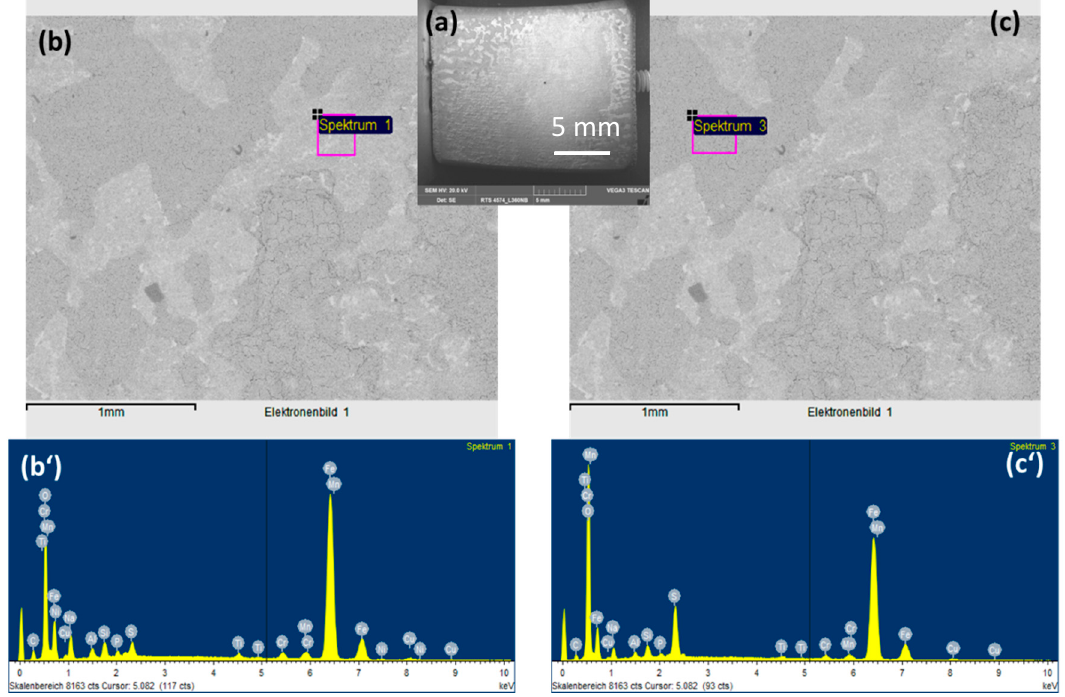
Figure 3. SEM images ( a , b , c ) and EDS spectra of brighter ( b’ ) and darker ( c’ ) areas of 7-day-exposed L360NB in Ar saturated condensate.